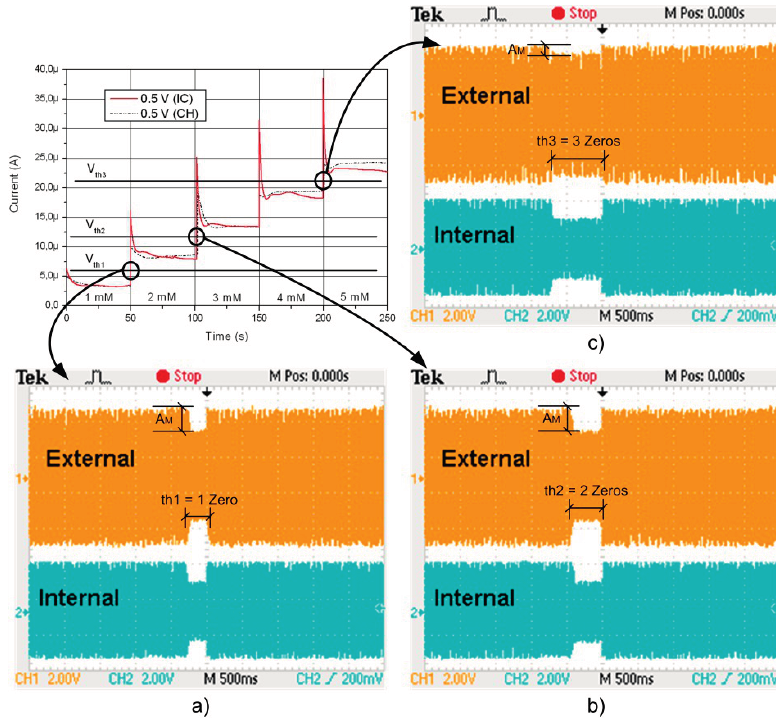
Figure 10. Amperometries measured with the prototype with three current levels programmed (Reproduced from [60] with kind permission from Springer Science + Bussiness Media